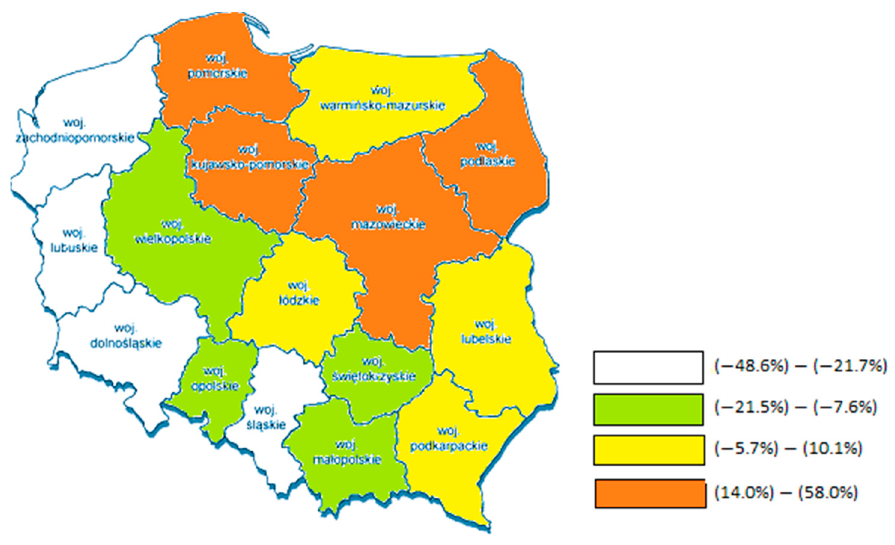
Figure 3. Change in the distribution of the relative gross value added per person employed in section A (agriculture, forestry, hunting, and fishing) for voivodeships in 2003–2019. (Own study, based on the Local Data Bank).